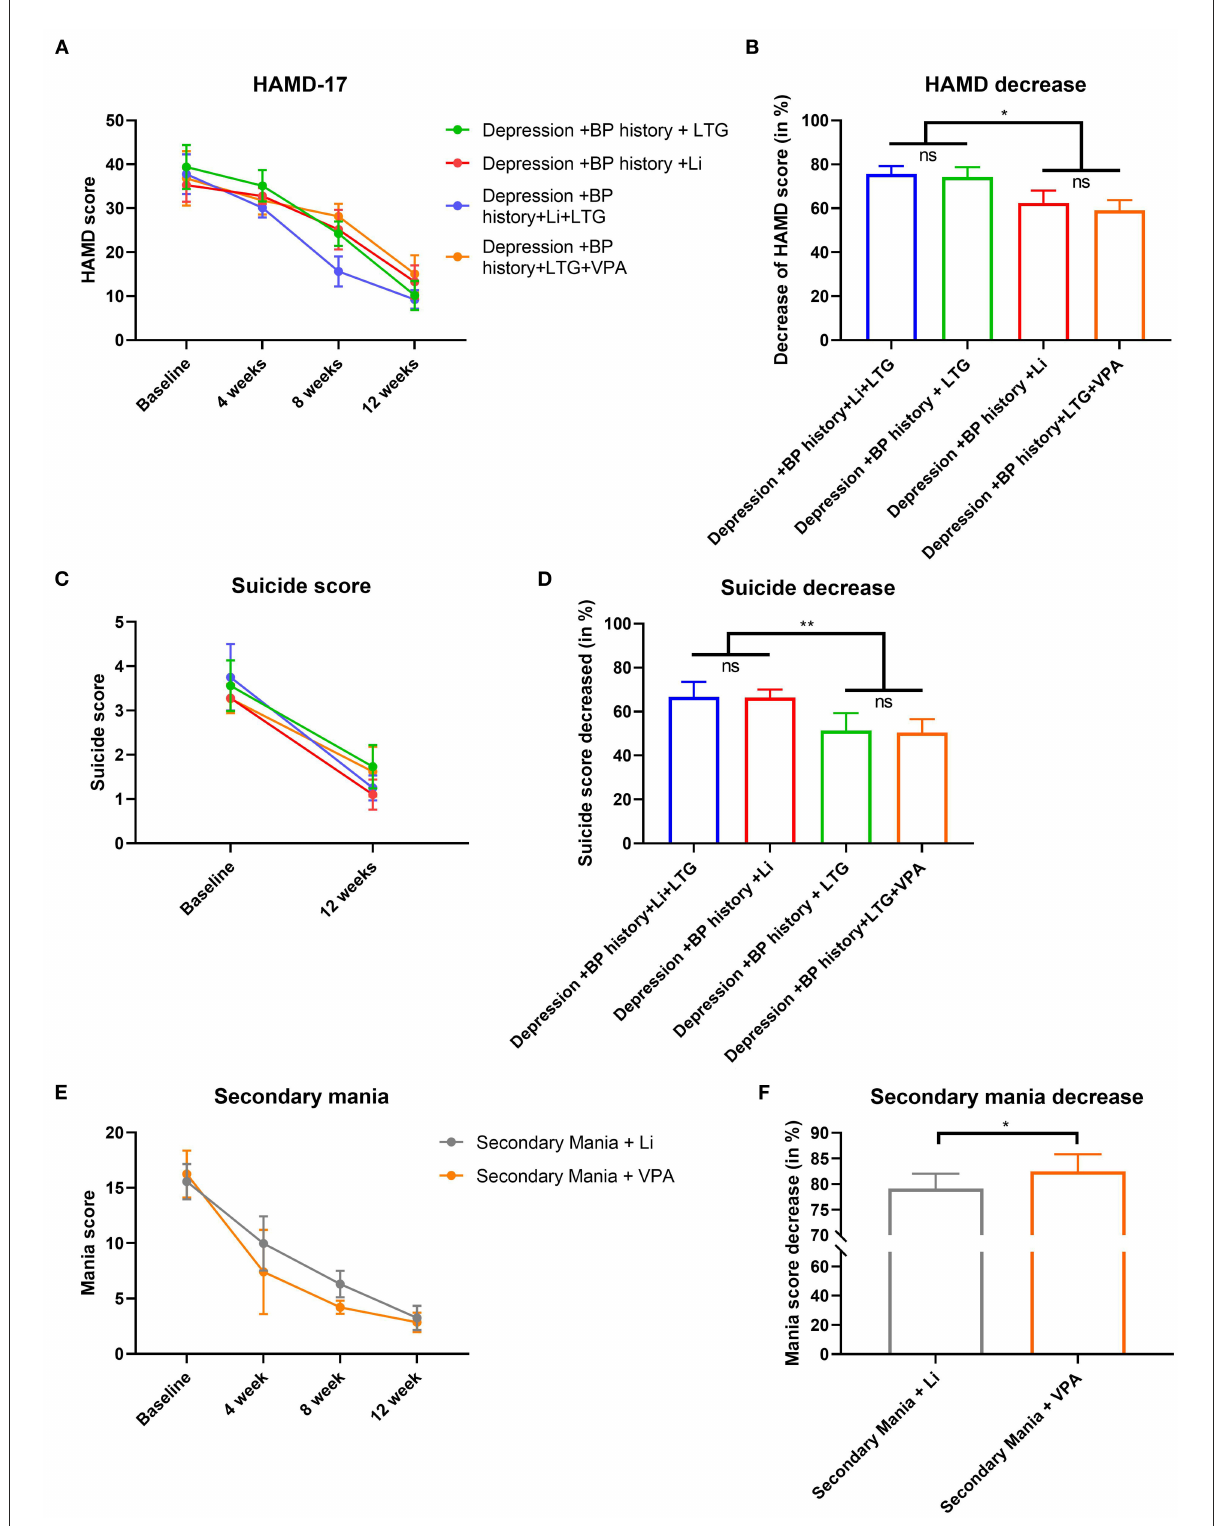
FIGURE5 Effects treatments on HAMD-17, suicidality or BRMS scores of patients with BP. For patients experiencing their first depressive episodes, (A) HAMD-17 scores before treatment and at 4, 8, and 12 weeks; (B) reductions in HAMD-17 scores; (C) suicidality scores before and after 12 weeks of treatment; (D) reductions in suicidality scores. For patients experiencing their first manic episodes, (E) BRMS scores before treatment and at 4, 8, and 12 weeks and (F) reductions in BRMS scores. HAMD-17, the 17-item Hamilton Depression Rating Scale; BRMS, the Bech-Rafaelsen Mania Rating Scale; BP, bipolar disorder. * p < 0.001 and ** p <